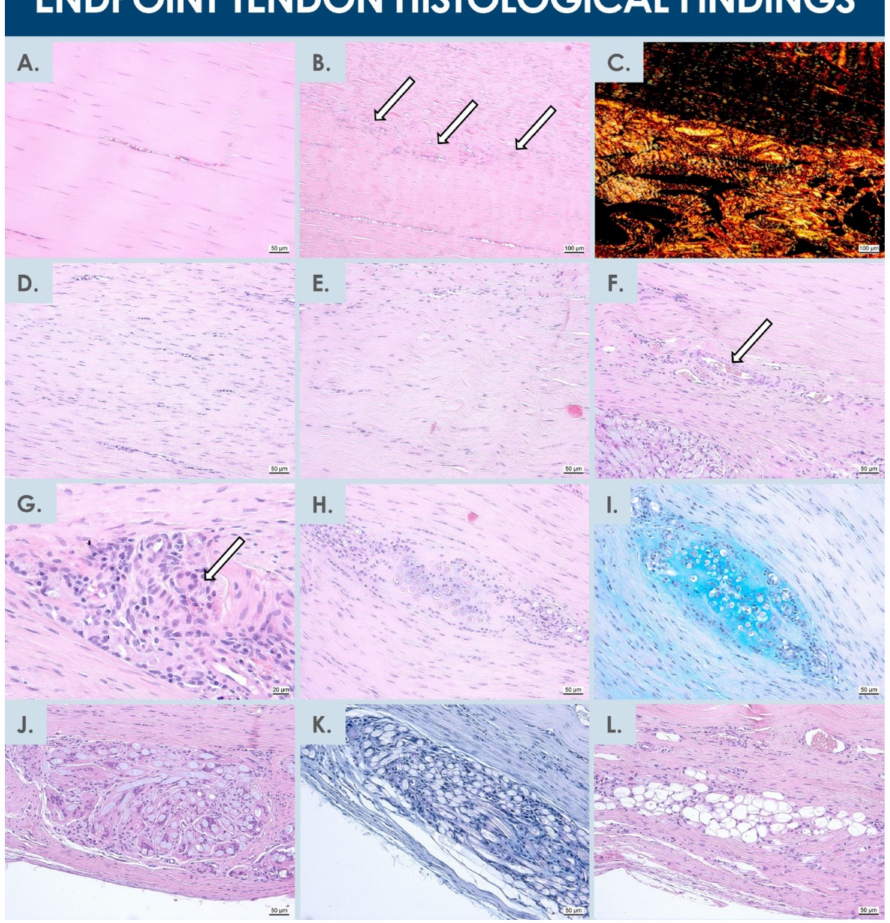
Figure 6. Microscopic patterns which could be observed on harvested tendon sections stained with hematoxylin–eosin (HE), Picrosirius Red (SR), or Alcian Blue stains (AB), and which were taken into account during the scoring process. ( A ) Normal structure of an untreated tendon with tenocytes dispersed in the matrix and with presence of a naturally aligned blood vessel, HE staining. ( B ) Delimitation of a defect (i.e., indicated by arrows) in an operated tendon, HE staining. The upper part of the picture shows the repaired defect and the bottom part shows normal tissue structure with a standard blood vessel. ( C ) The delimitation of a defect could be facilitated by an observation with Picrosirius Red staining under polarized light. The upper part of the picture shows a natural structure with good alignment and low diffraction of light, while the bottom part shows more light reflection due to misalignment of collagen in the matrix. ( D ) Hypercellularity, HE staining. ( E ) Disorganization of tendon structure, with immature or disrupted tendon structure, with undulating fibers, HE staining. ( F ) Hypervascularity and presence of transverse vessels (i.e., indicated by the arrow), HE staining. ( G ) Immune cell reaction and presence of a foreign body giant cell (i.e., indicated by the arrow), HE staining. ( H–I ) Presence of remaining biomaterial, detectable with HE staining. Alcian Blue staining allows for an easier detection of remaining biomaterial, with bright blue coloring. ( J–K ) Presence of suture material, recognizable with HE staining. The AB staining allows to exclude the presence of biomaterial, as there is no bright blue coloring. ( L ) Presence of open spaces, HE staining. Scale bars = 20, 50, or 100 µ